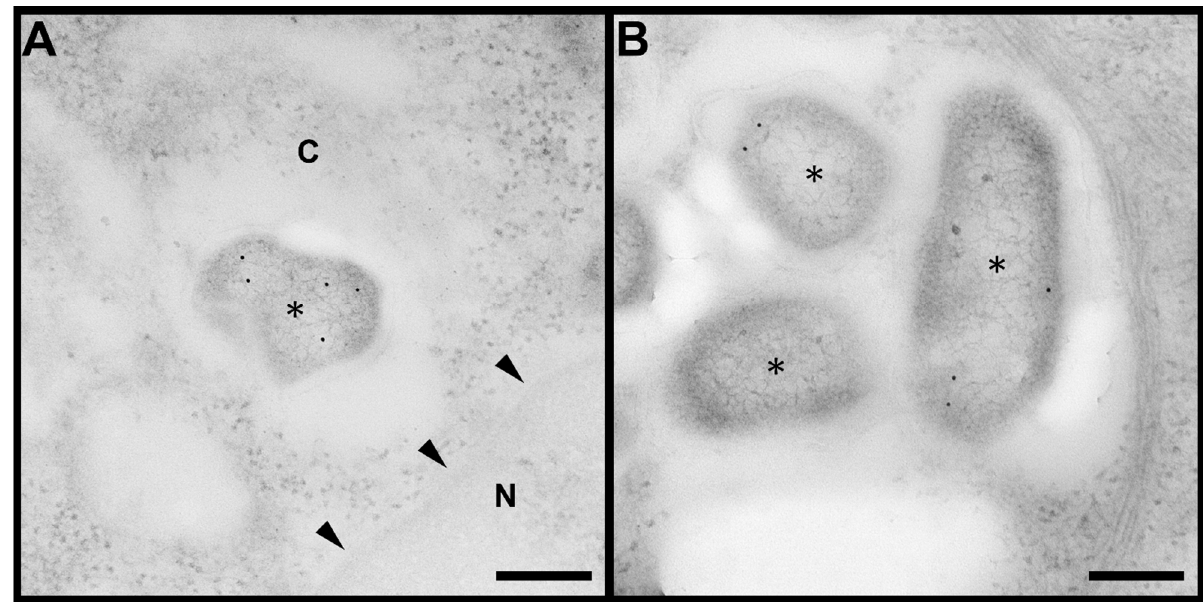
Figure 2. Immunoelectron microscopy analysis of GapA localization inside bacteria in infected host cell. The protein distribution was usually uniform 2 h p.i. ( A ), but apparently changed to predominantly peripheral 12 h p.i. ( B ). Bacteria marked with asterisk (*). Image A displays nucleus (N) and cytoplasm (C) with arrowheads pointing to nuclear membrane. Image B displays area in cytoplasm. Scalebar = 200 nm, gold nanoparticles = 12 nm.